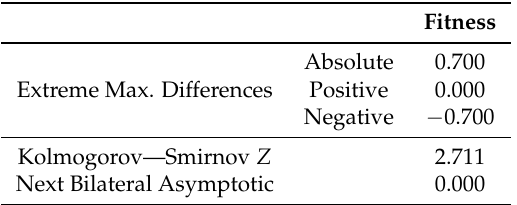
Table 5. Two independent sample Kolmogorov–Smirnov test. Statistics Grouping variable: